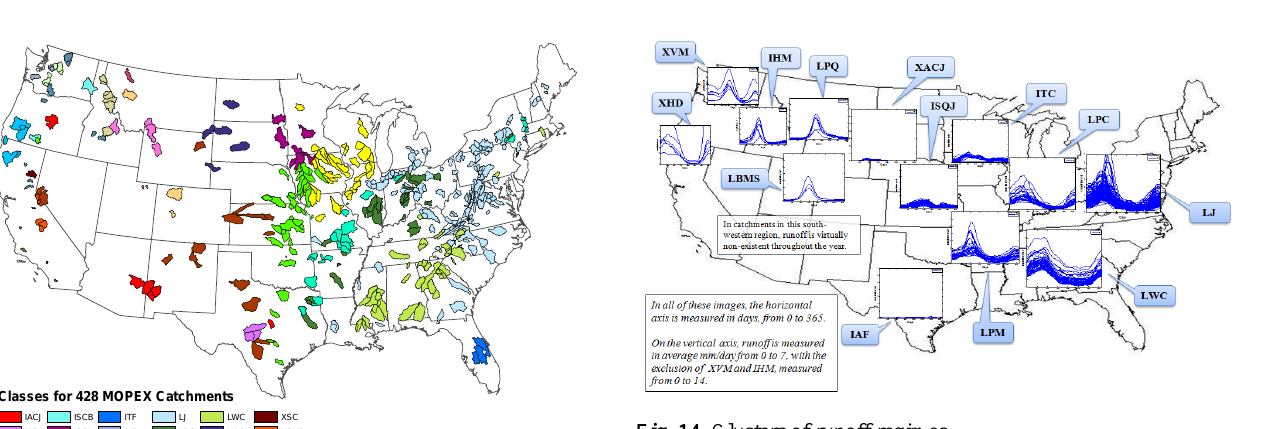
Fig. 14. Clusters of runoff